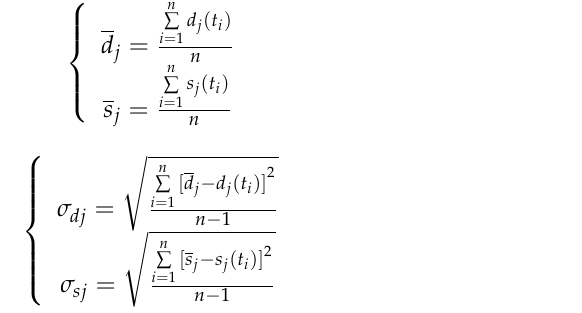
Figure 10. The influence of different parameters on the first 40 natural frequencies: ( a ) Span; ( b ) Rise–span; ( c ) Internal pressure; ( d ) Cable configuration.